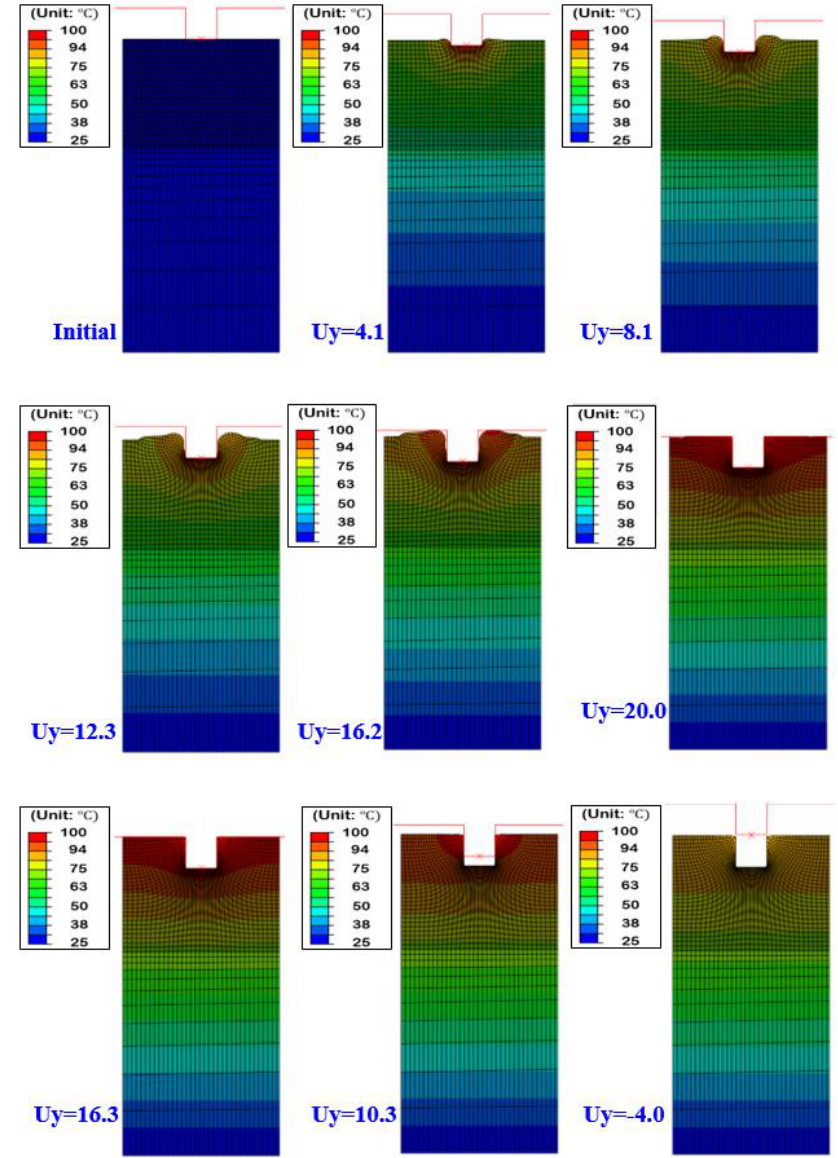
Figure 9. Deformed shapes and temperature distribution (Tool: 100 °C, Sheet: 25